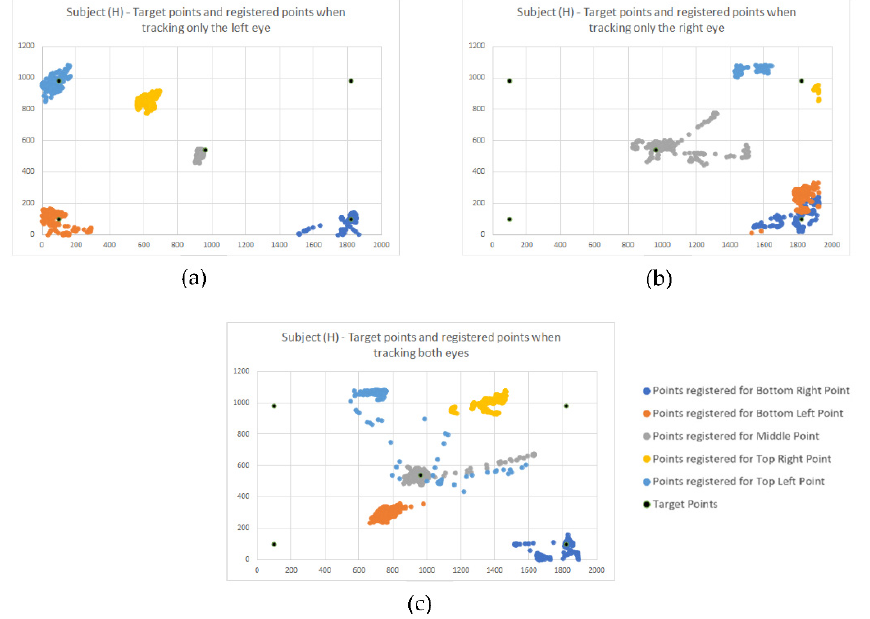
Figure 4. ( a ) Plot of gaze dispersions recorded for the right eye, all target points, ( b ) plot of gaze dispersions recorded for the left eye, all target points, ( c ) plot of gaze dispersions recorded for both eyes, all target points.